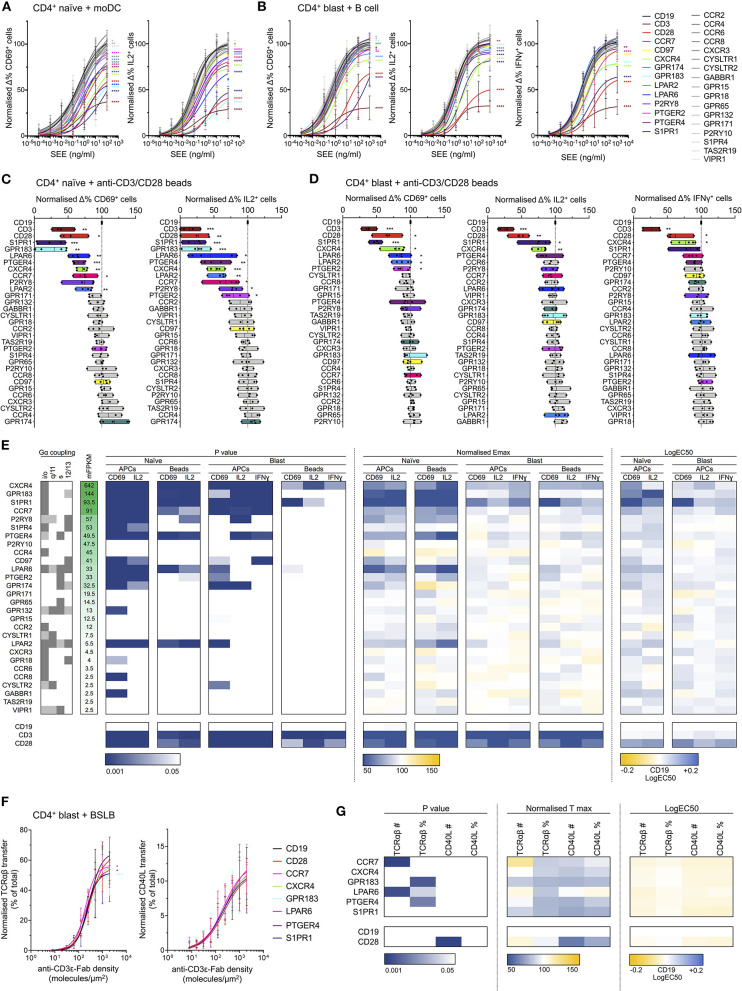
Effects of GPCR knockout in activation of naïve and blasted CD4+ T cells. (A) Normalized change in CD69+ (left) and IL2+ (right) naïve CD4+ T cells incubated with moDCs loaded with titrated concentrations of SEE. Plots show mean ± std dev., with best-fit non-linear response curves for each target. Datasets are colored according to target (key far right), with non-gray sets used only for targets exhibiting significant effects in both the CD69 and IL2 responses. Significance relative to the CD19 target data was assessed using an extra sum-of-squares F test and is indicated for all significant (p < 0.05) datasets. (B) Normalized change in CD69+ (left), IL2+ (center), and IFNγ (right) blasted CD4+ T cells incubated with B cells loaded with titrated concentrations of SEE. Data are represented as in A. (C) Normalized change in CD69+ (left) and IL2+ (right) naïve CD4+ T cells incubated with anti-CD3/CD28 beads. Boxes show mean, minimum, and maximum values, significance is shown relative to CD19 as assessed with a two-tailed t-test. Non-gray datasets are colored as in A. Each point represents a different T cell donor. (D) Normalized change in CD69+ (left), IL2+ (center), and IFNγ (right) blasted CD4+ T cells incubated with anti-CD3/CD28 beads. Data are represented as in C. (E) Summarized GPCR knockout screen data. Calculated F test p-values, normalized Emax, and logEC50 for all assays are represented as a heatmap, colored according to the corresponding scales below. For T cell-APC assays, Emax was derived as the value of the fitted response curve at the highest SEE concentration. Reported G protein coupling for each GPCR is shown as dark gray (primary coupling), light gray (secondary coupling), or white (no coupling), as listed in the GPCR database (gpcrdb.org). Receptors are ordered according to mean FPKM (mFPKM) values in RNA-seq from primary total or effector memory CD4+ T cells (E-MTAB-3827). (F) Normalized transfer of TCRαβ (left) or CD40L (right) from CD4+ blasts to BSLBs presenting ICAM1, CD40, and titrated densities of UCHT1, as a percentage of total cellular TCRαβ/CD40L. Data are represented as in A. (G) Summarized BSLB transfer assay data. Calculated F test p values, normalized Tmax, and logEC50 for all assays are represented as a heatmap, colored according to the corresponding scales below. Values are shown for raw amount of protein transferred (TCRαβ# or CD40L#) or as a percentage of total cellular protein (TCRαβ% or CD40L%). *p < 0.05, **p < 0.01, ***p < 0.001, ****p < 0.0001. All pooled data represent a minimum of n = 4 independent donors.